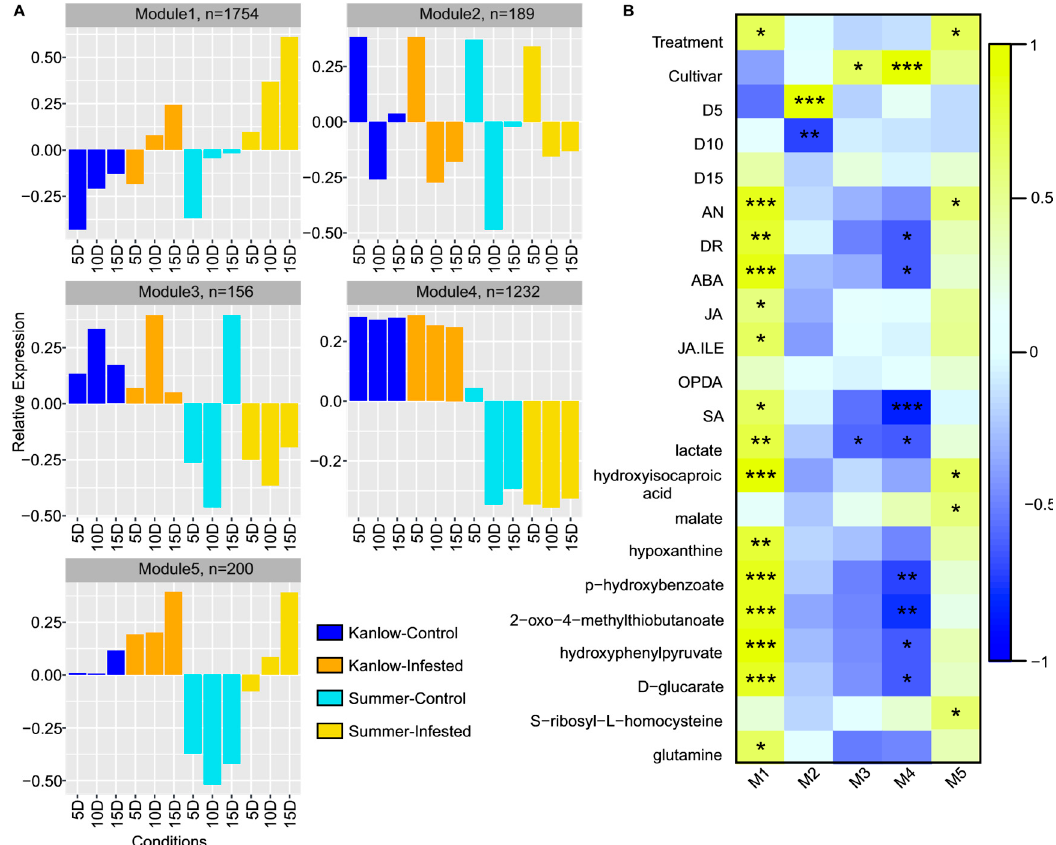
Figure 6. Weighted gene co-expression network analysis (WGCNA) of the 3531 DEGs. ( A ) Expression patterns of genes assigned to five co-expression modules, n indicate the number of DEGs in each WGCNA module. ( B ) WGCNA module and cultivar traits: aphid number (AN), damage rating (DR), hormones, and metabolites relationships. Each column corresponds to a module. Each cell contains the corresponding correlation level (blue–yellow scale) and p -value ( − Inf < *** < 0.001, 0.001 < ** < 0.001, 0.01 < * < 0.05). For treatment, infested conditions were assigned to 1, and control conditions were assigned to 0. For cultivar, Kanlow conditions were assigned to 1, and Summer conditions were assigned to 0.